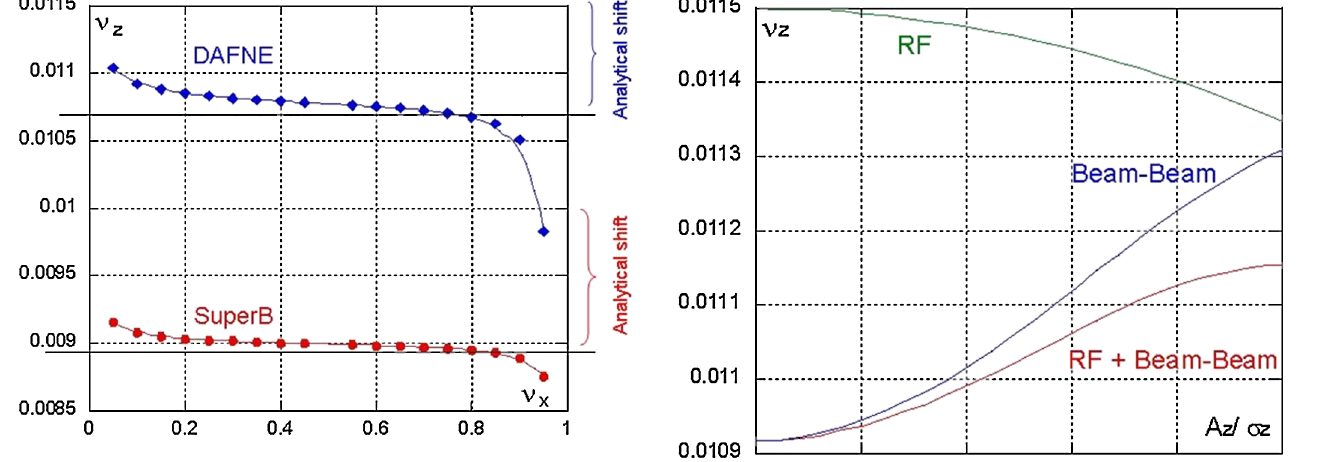
contributions).FIG. 8. Synchrotron tune dependence on the horizontal tune. The solid straight lines correspond to the analytically predicted synchrotron tunes (last row in Table